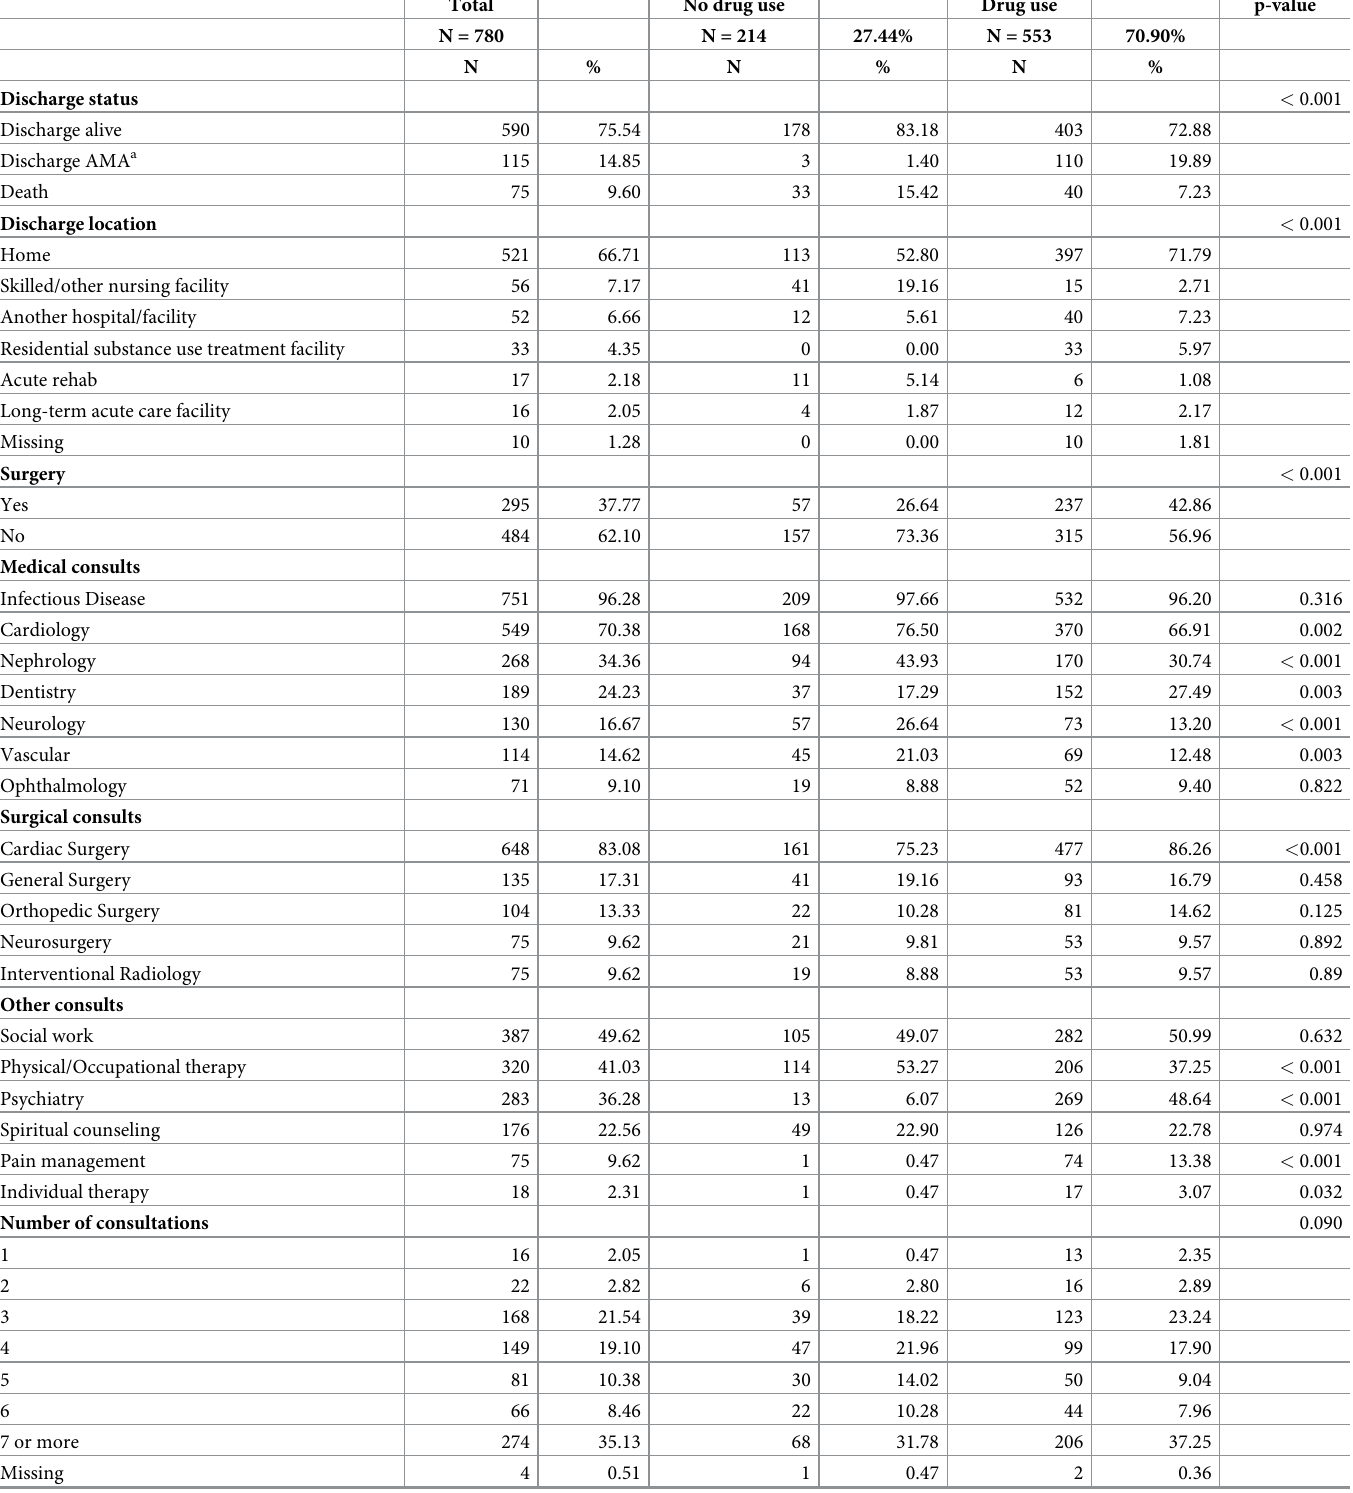
Table 4. Hospital utilization by patients with infective